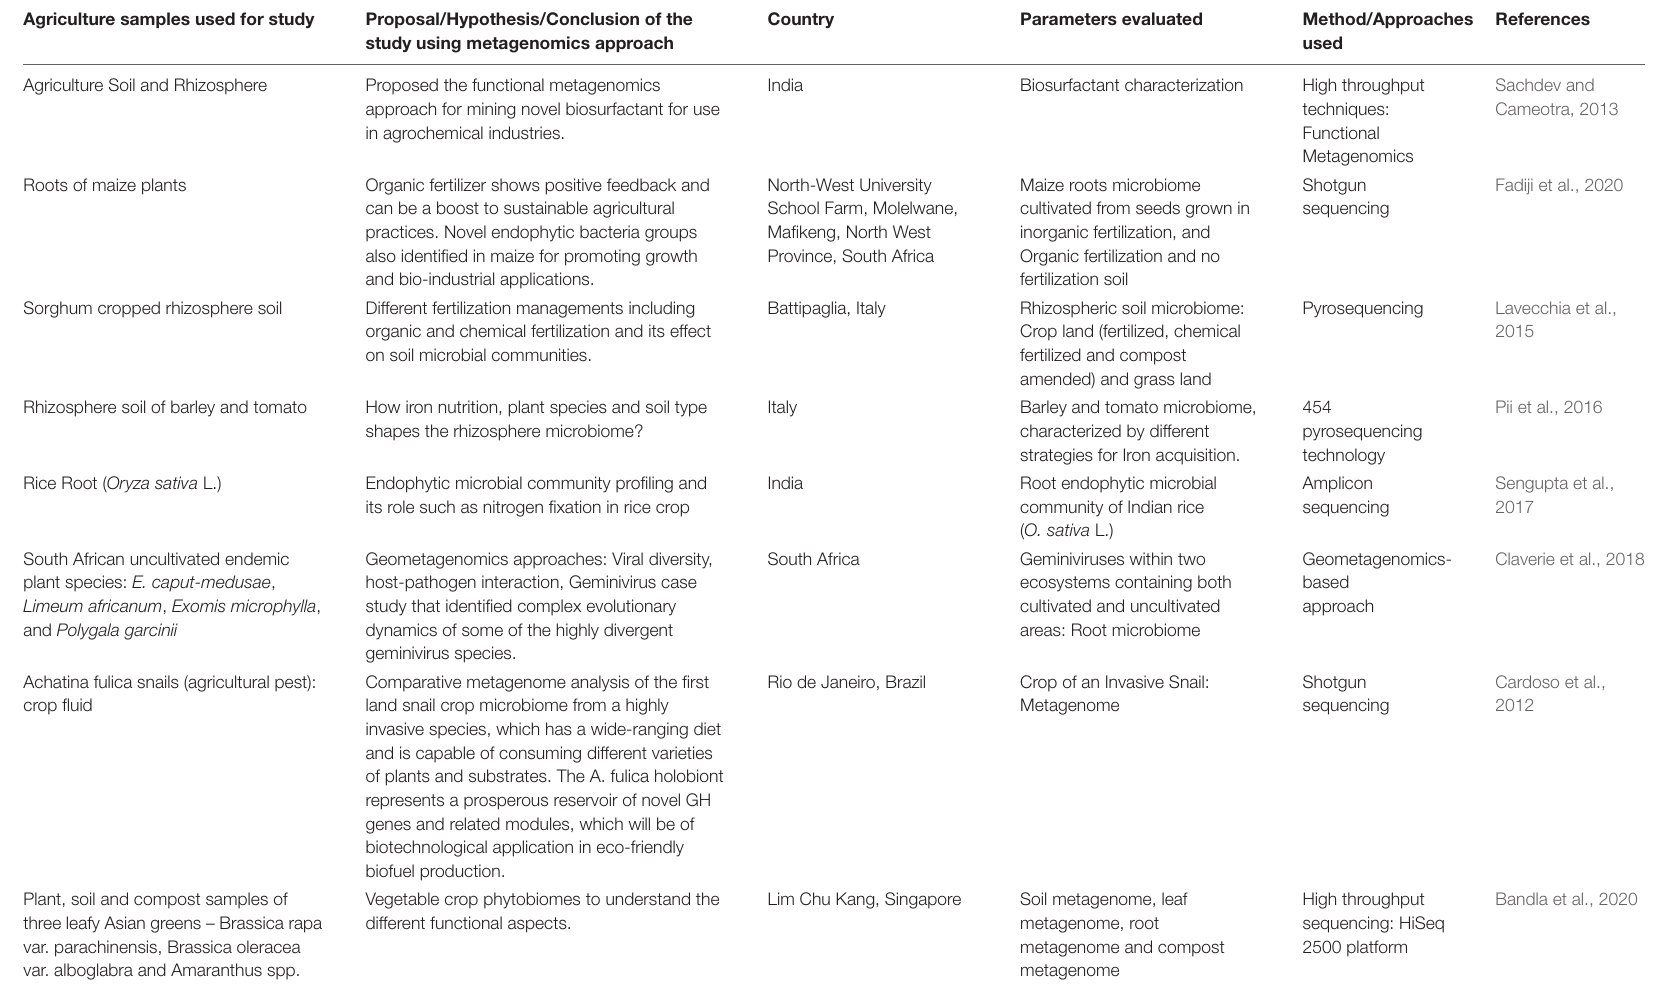
TABLE 3 | Overview of metagenomics applications in